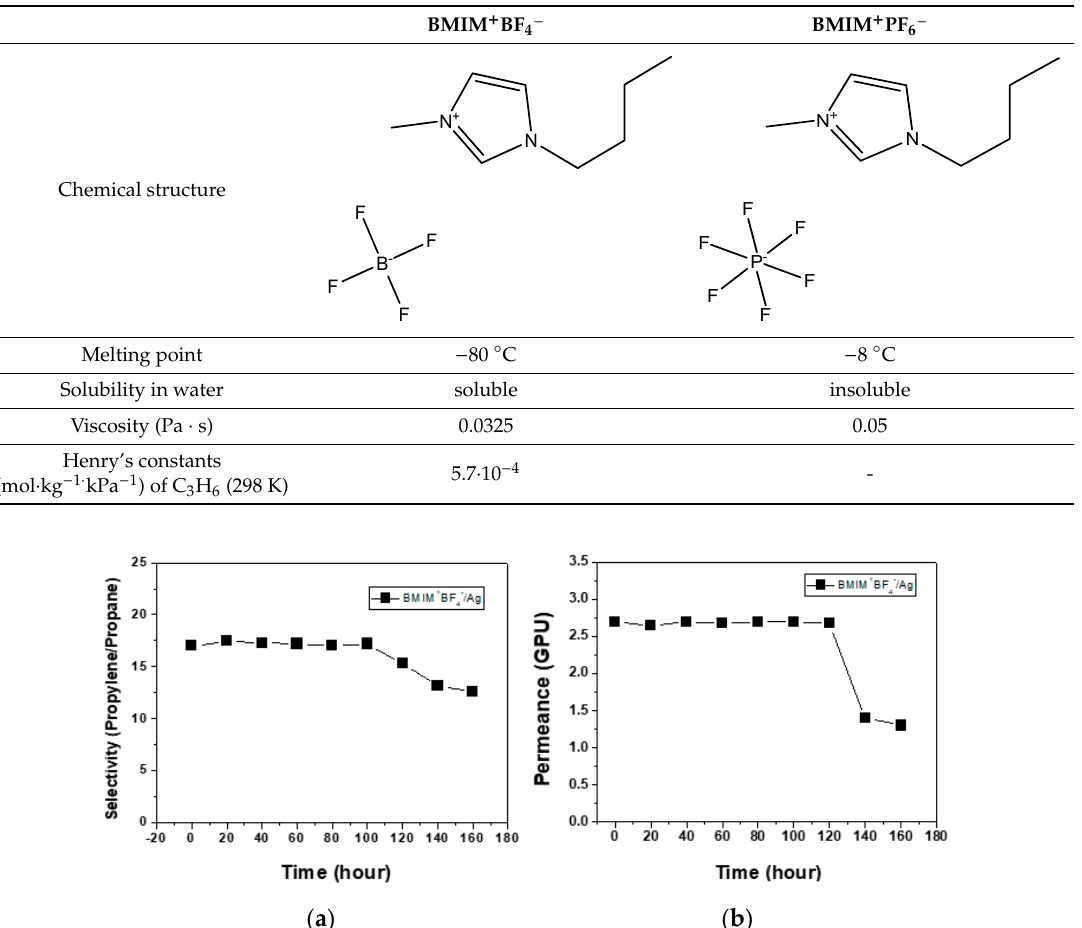
Table 2. Properties of BMIM + BF 4- and BMIM + PF 6-.